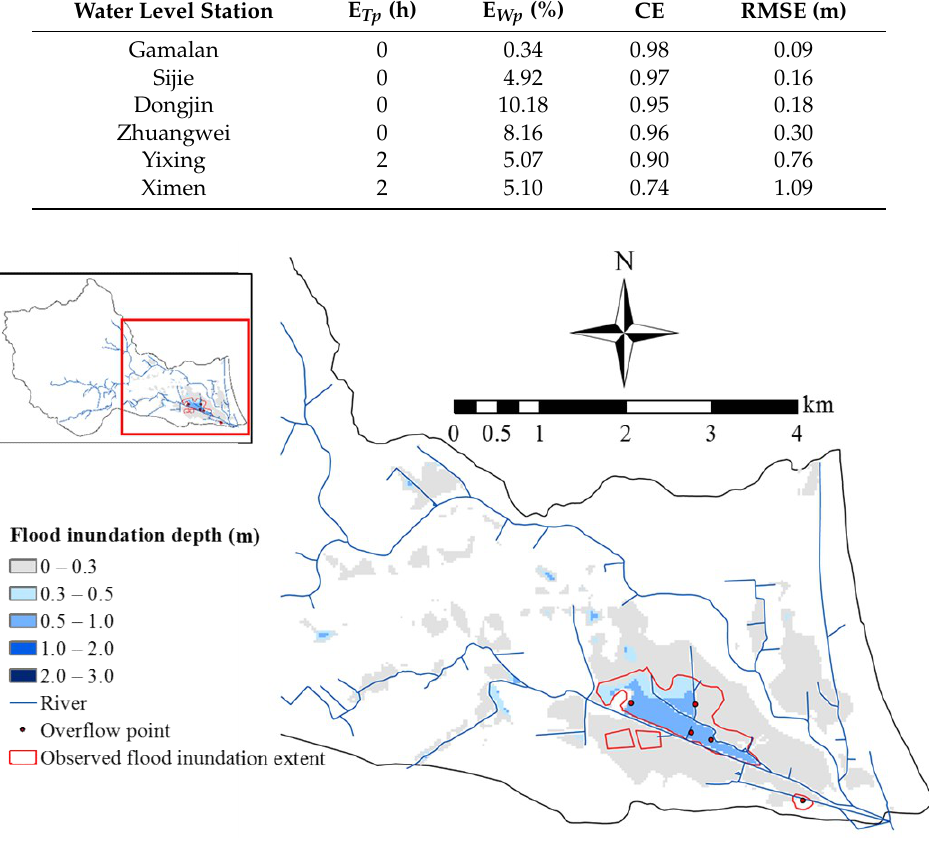
Table 3. Hydrologic descriptions and dominant clusters for flood gauging